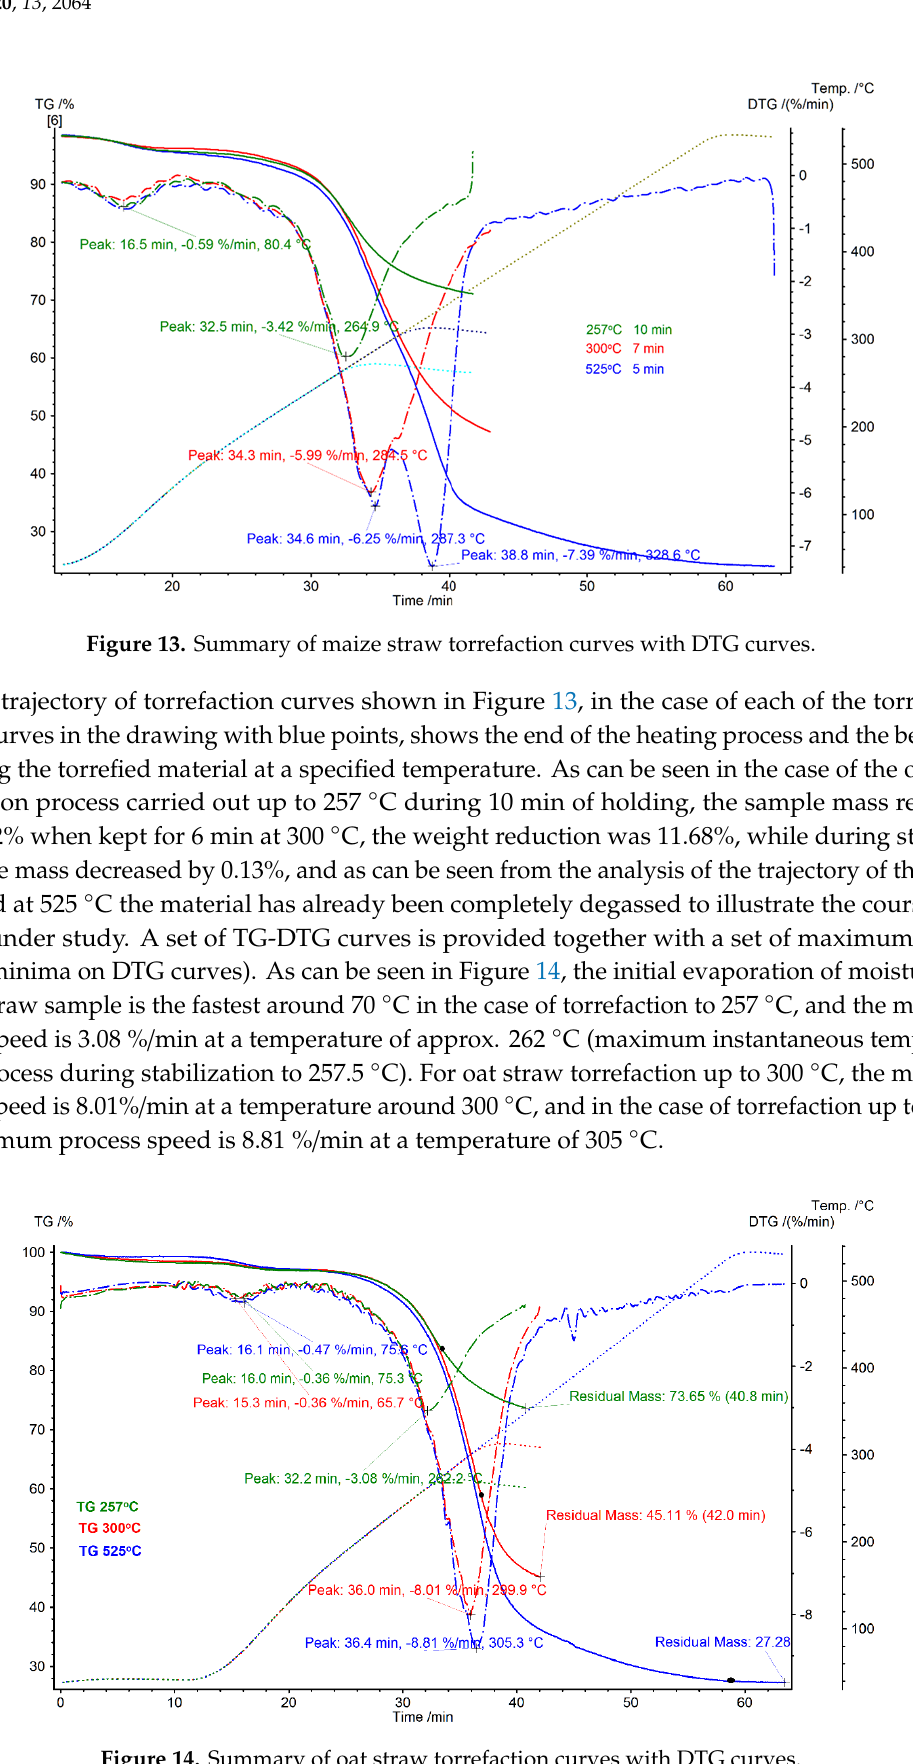
Figure 14. Summary of oat straw torrefaction curves with DTG curves.